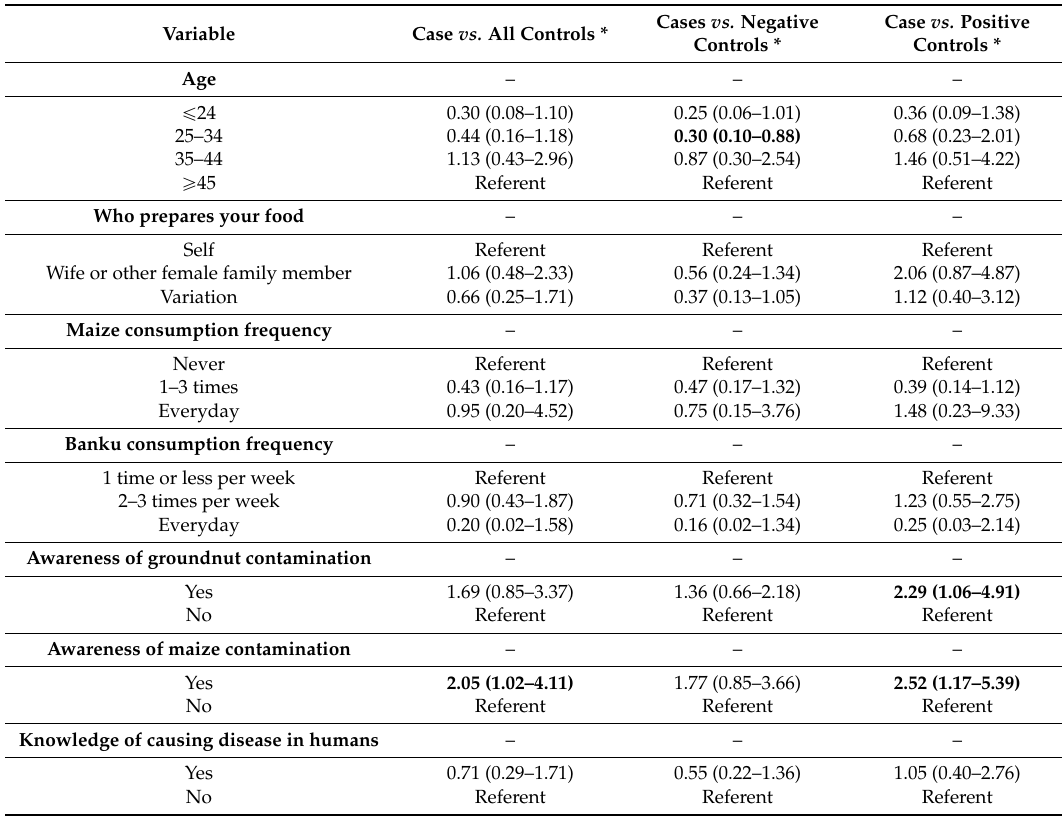
Cases vs. Negative Controls